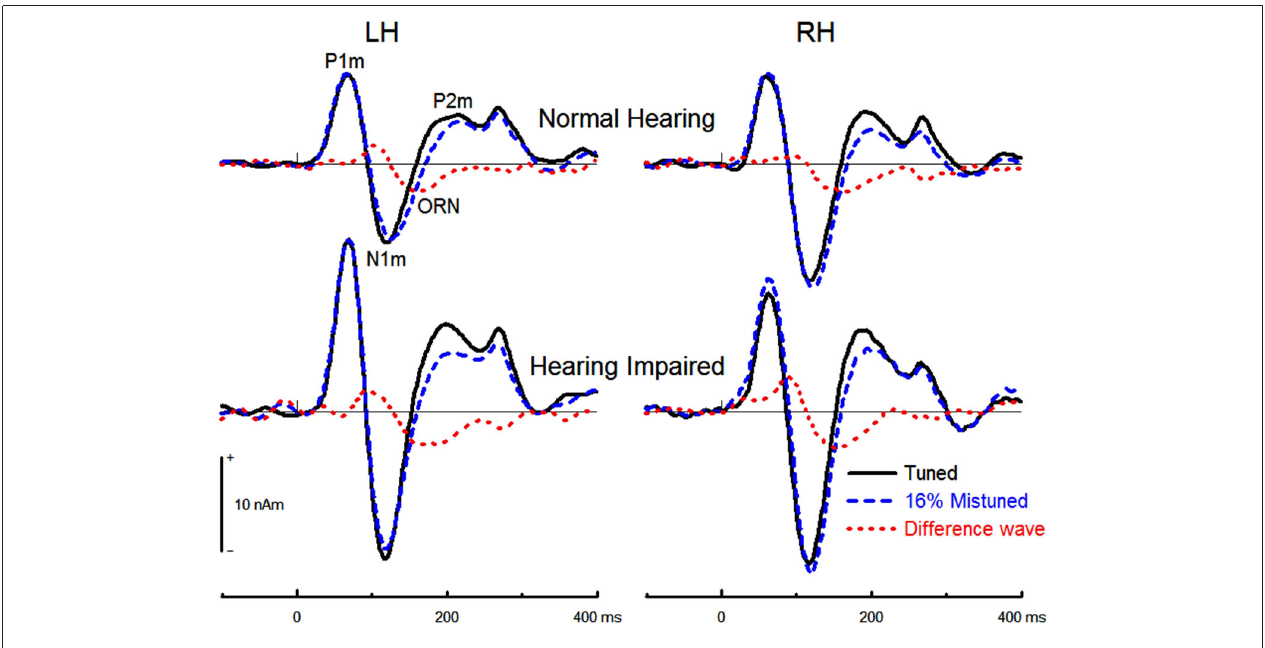
effect of hearing status was not significant ( F ( 1,32 ) = 2.10, P = 0.16) nor was the effect of noise ( F < 1) or hemisphere ( F ( 1,32 ) = 2.70, P =